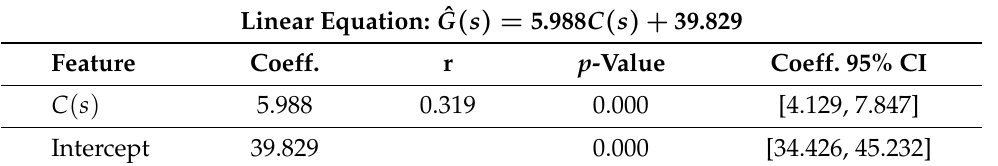
Table 14. OLS regression summary—average number of weekly active days against Grade.